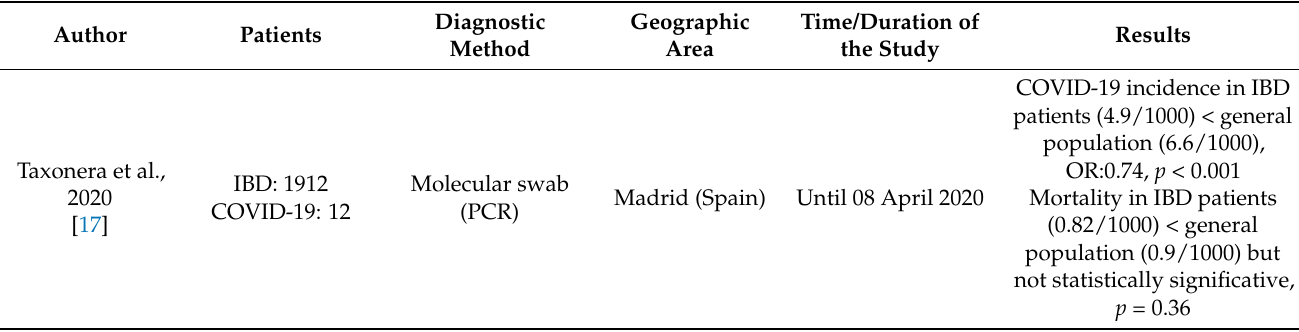
Table 2. COVID-19: are IBD patients protected from the